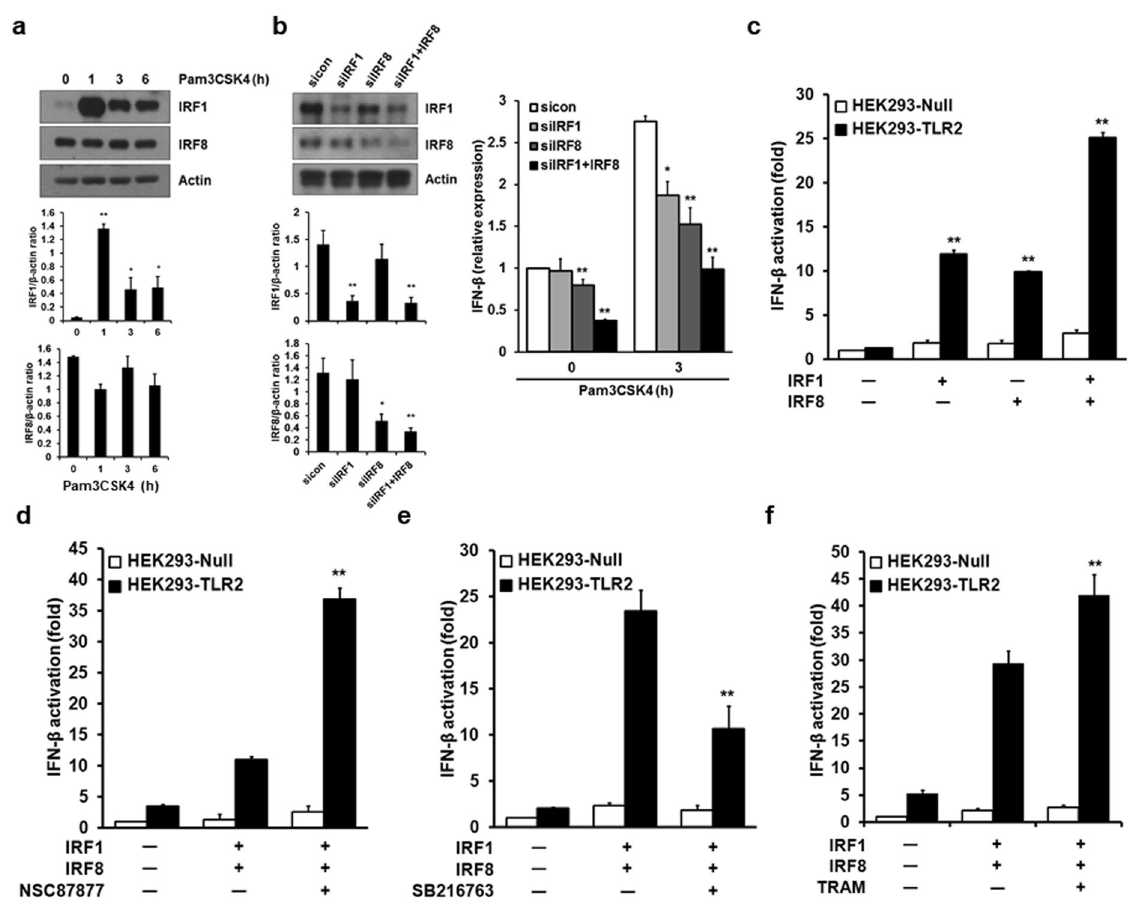
Figure 4. IRF1 and IRF8 are involved in IFN- β induction by TLR2 ligands. ( a ) BMDMs were stimulated by 1 μ g/ml Pam3CSK4 for the indicated time. IRF1 and IRF8 levels were detected by Western blotting. ( b ) 50 nM control siRNAs (sicon) or IRF1- and IRF8-specific siRNAs (siIRF1 and siIRF8) were transfected into BMDMs and cells were stimulated with 1 μ g/ml Pam3CSK4 for 3 h. IRF1 and IRF8 protein levels were determined by Western blotting, and IFN- β mRNA expression was measured by real-time-PCR. ( c ) HEK293-Null or -TLR2 cells were co-transfected with an IFN- β luc promoter and an IRF1 or IRF8 expression vector alone or in the indicated combinations. After 48 h, cells were stimulated with 1 μ g/ml Pam3CSK4 for 1 h. Firefly and Renilla luciferase activities were determined, and data were normalized to the activity of Renilla luciferase. ( d ) HEK293-Null or -TLR2 cells were co-transfected with the IFN- β luc promoter and IRF1 and IRF8 expression vectors in the indicated combinations. After 48 h, cells were pretreated with 50 μ M NSC87877 for 1 h and stimulated with 1 μ g/ml Pam3CSK4 for 1 h. The experiment was performed as described in ( c ). ( e ) As in ( d ), except that the cells were pretreated with 5 μ M SB216763 for 30 min. ( f ) HEK293-Null or -TLR2 cells were co- transfected with the indicated combinations as in ( d ). Representative Western blots and quantification (shown in the bar graph) of indicated proteins/control ratio in the lysates of cells are shown in ( a , b ). Data represent the means of triplicate samples ± SD and are representative of at least three experiments. Statistical analyses were carried out using Student’s t -test ( * P < 0.05, ** P < 0.01). The uncropped images are in Supplementary Fig.